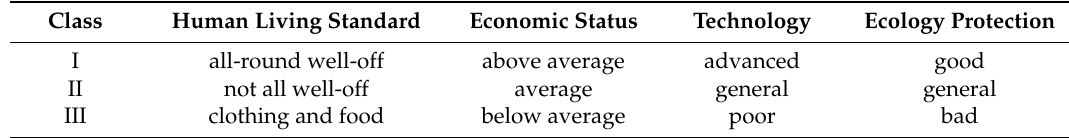
Table 2. Three design socio-economic development